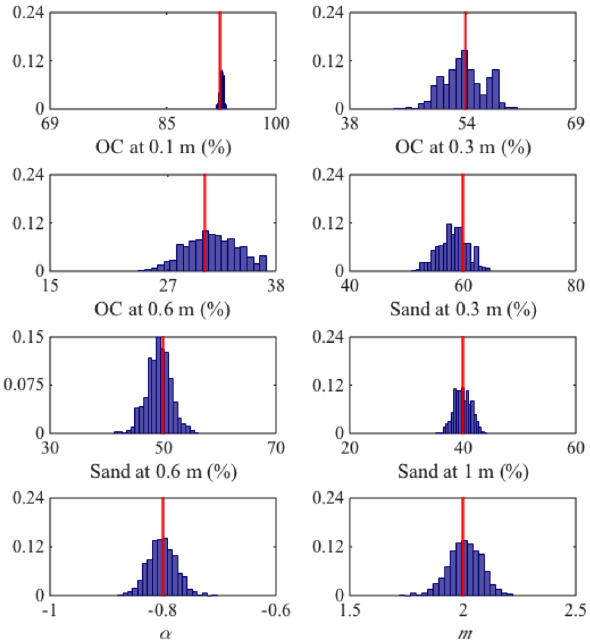
Figure 11. The a posteriori probability of soil OC content at z = 0 . 1, 0.3 and 0.6m; sand content at z = 0 . 3, 0.6 and 1m; and petro- physical parameters m and α for scenario 9. The sand content is the fraction of sand in the sand–clay mineral mixture. Soil porosity is determined as a function of soil OC and sand content in the CLM. The red line represents the “true” parameter